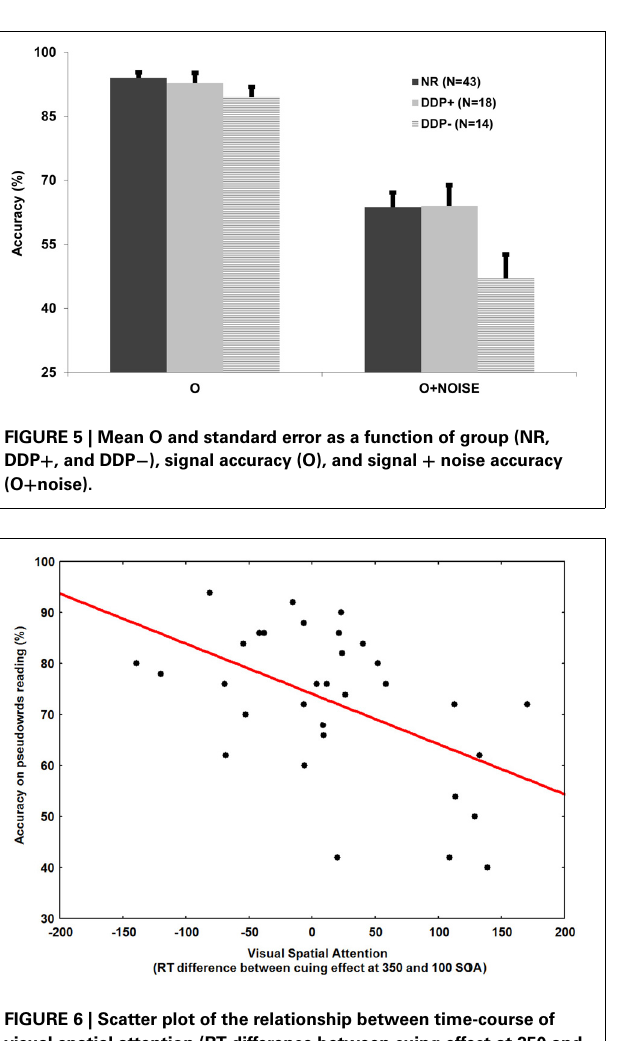
accuracy mean in the O + noise condition. Phonological abilities were measured by using the efficiency in the PPB and PSTM tasks. The main results showed that phonological decoding was sig- nificantly correlated with both spatial and temporal attention as well as phoneme blending (see Figures 6 , 7 ). In addition, irregu- lar word reading was correlated with both phonological tasks and VSA. Finally, temporal and spatial attention were highly corre- lated to each other (see Table 5A ). The same bivariate correlations were computed in our entire sample ( N = 75), including the NR children, confirming the relationship between visual attention and phonological decoding (see Table 5B